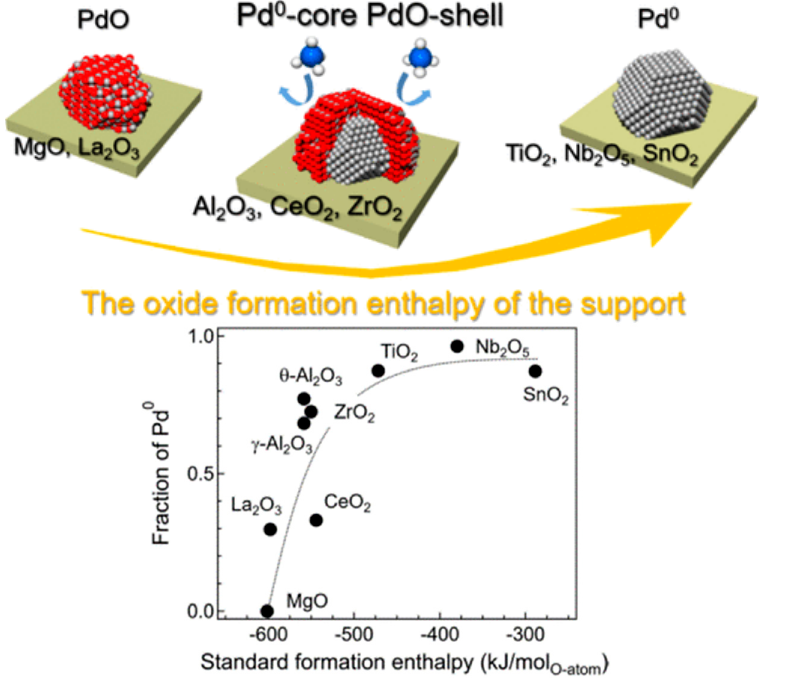
Figure 6. Effect of ∆ f H M-O 0 value i.e., the standard formation enthalpy of metal-oxygen bond on the oxide on the stabilization of {Pd n+ -O} species supported on different metal oxides. Adapted from [14] with permission.